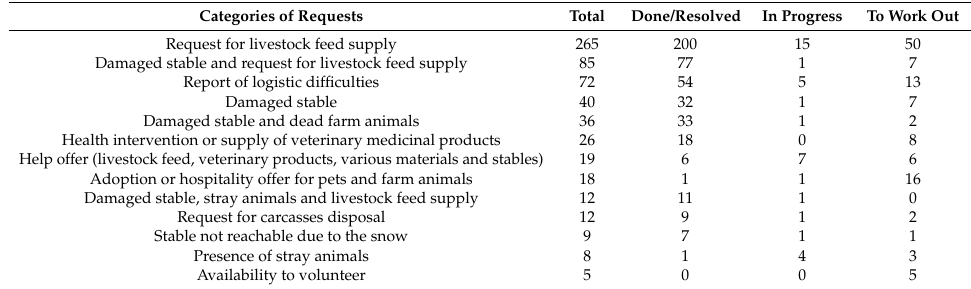
Figure 2. A flow chart outlining the reporting structure for animal health services in Italy. Table 3. Assistance calls received by National Reference Center for Veterinary Urban Hygiene and Non-Epidemic Emergencies (IUVENE) help desk.